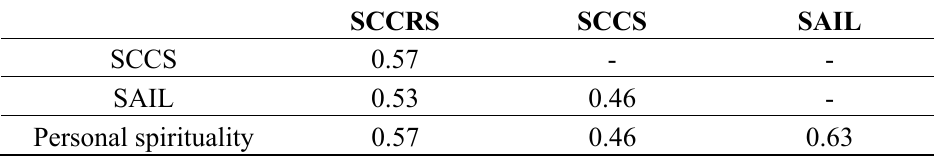
Table 4. Correlations summary scores of standardized